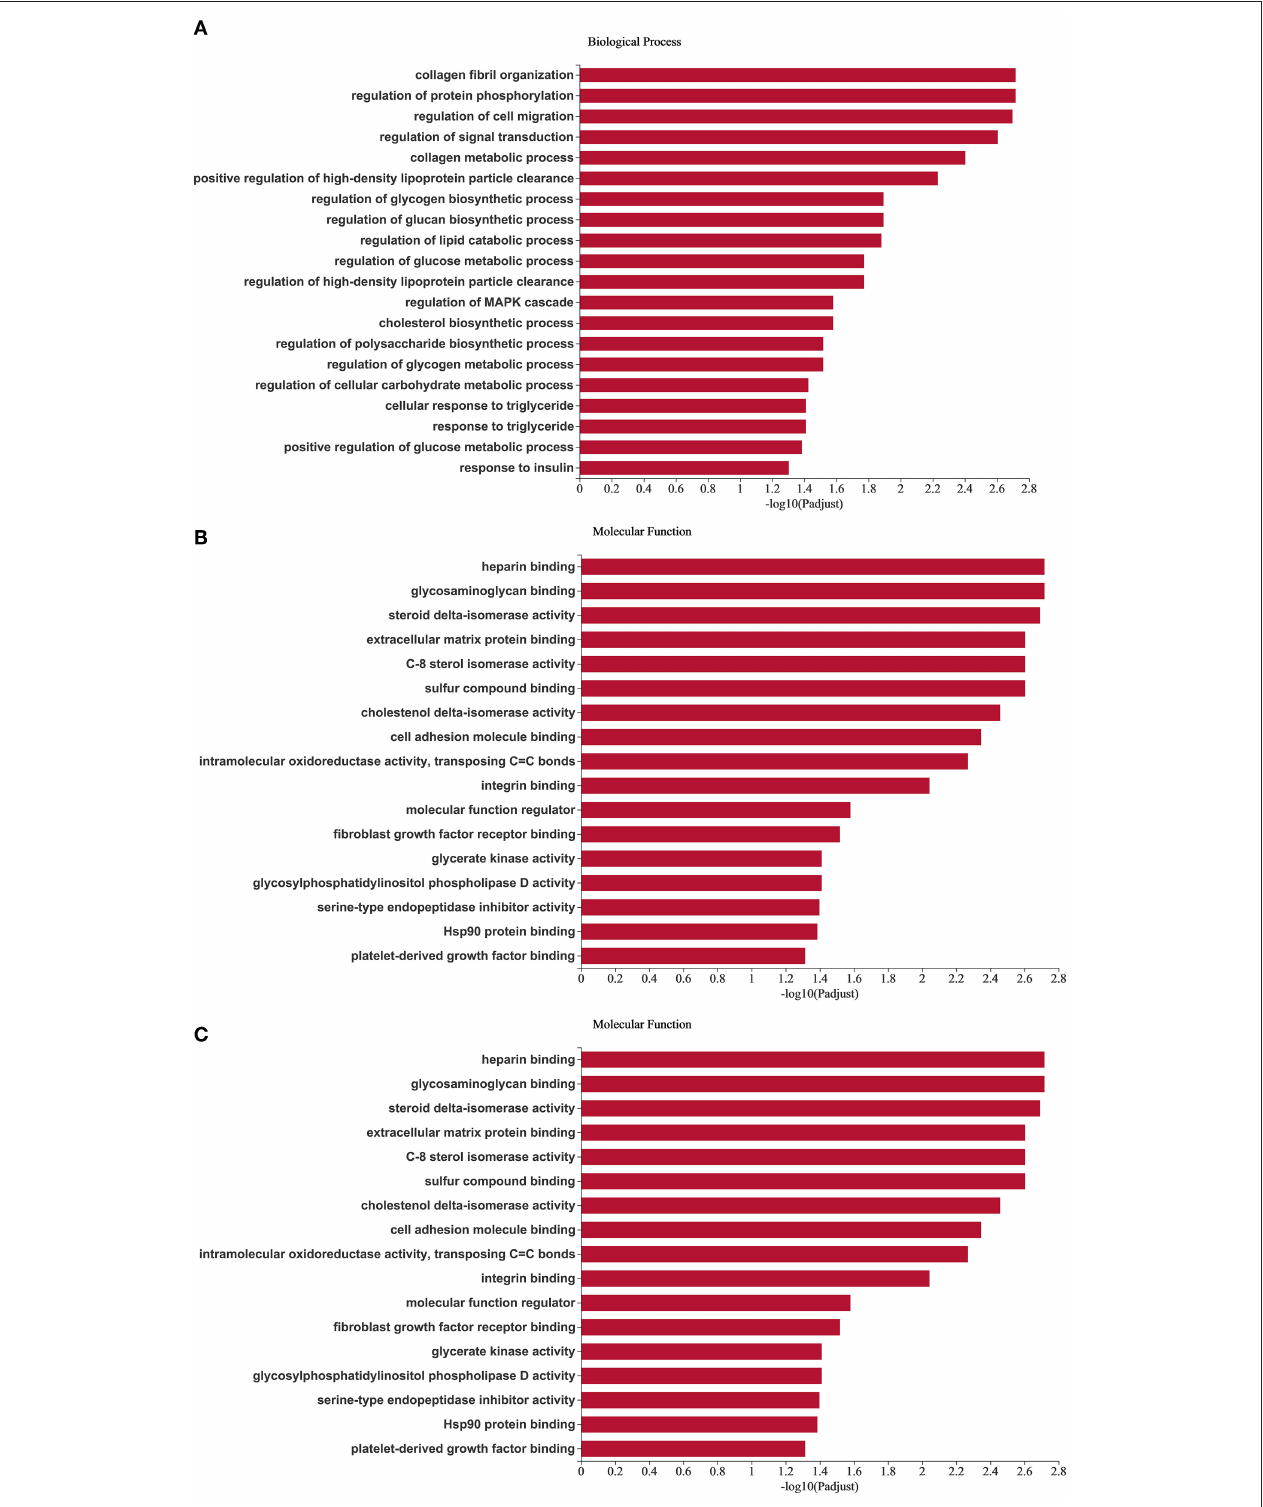
FIGURE 5 | GO enrichment analysis of target genes. (A–C) Are biological processes, molecular function, and cellular component, respectively. The X-axis is the enrichment significance, and the Y-axis is GO term.